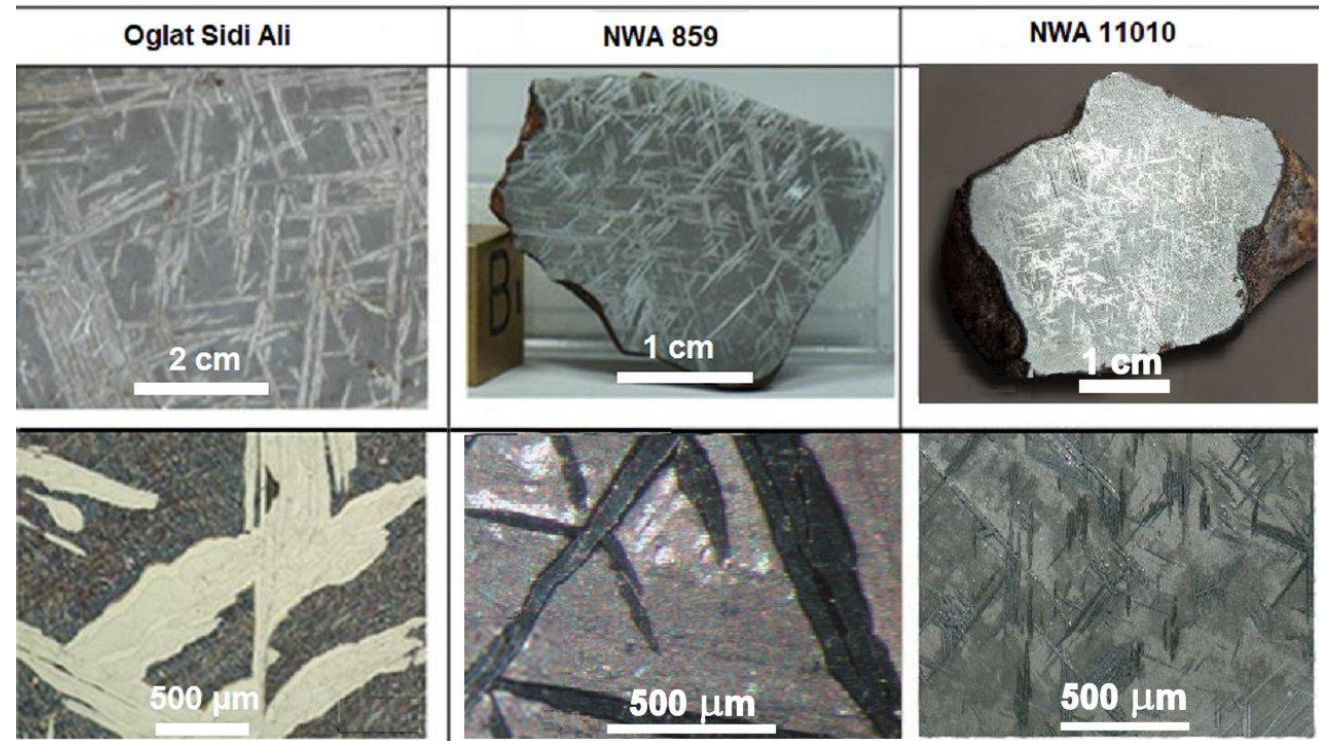
Figure 12. Hand-size specimen and stereomicrograph images of the textures of the Oglat Sidi Ali, NWA 859 and NWA 11010 meteorites. NWA 11010 photos courtesy of T. DeLisle, Pisgah Astronomical Research Institute (hand-size specimen) and by A. Love, Appalachian State University, sample# ASU-NWA-98 (stereomicrograph image).